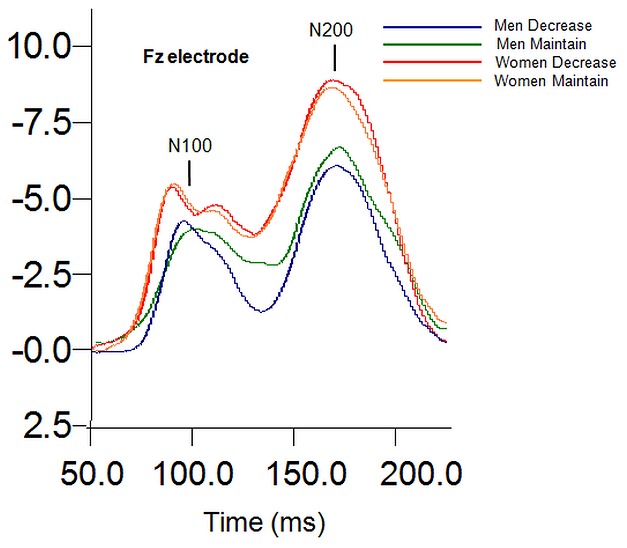
The Site×Sex interaction for mean N100 amplitude to the “decrease” instructional set.